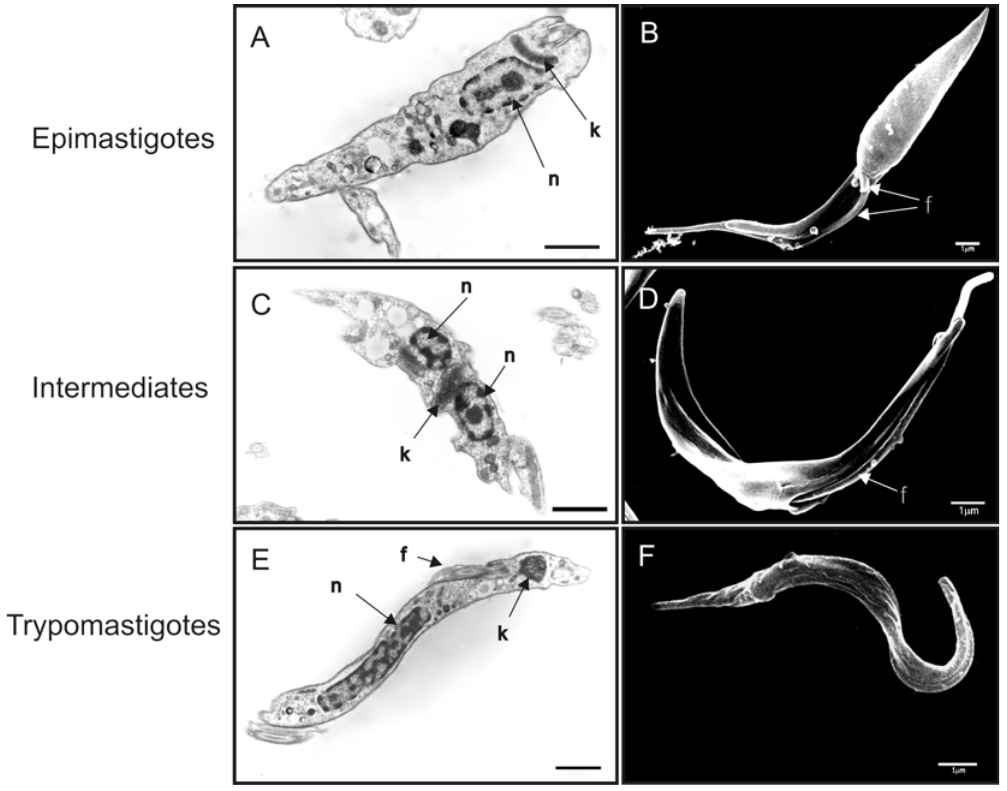
Fig. 4 – Ultrastructure details of epimastigote, intermediate and metacyclic-trypomastigotes. The figure show transmission (left panels) and scanning electron micrographs (right panels) of T. cruzi forms obtained during meta- cyclogenesis. The letters indicate the kinetoplast (k), the nucleus (n) and the flagellum (f). Bars = 1 µ m.